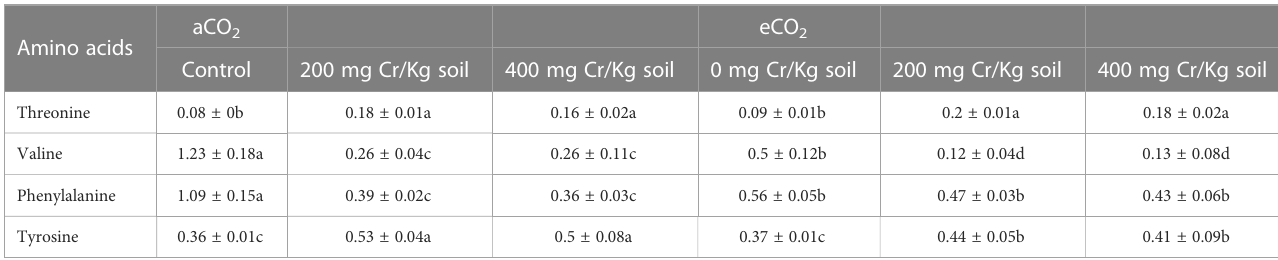
TABLE 4 Effect of Chromium (Cr) exposure on fatty acids pro fi le of rice grains produced under either aCO 2 (410 ppm) or eCO 2 (620 ppm).